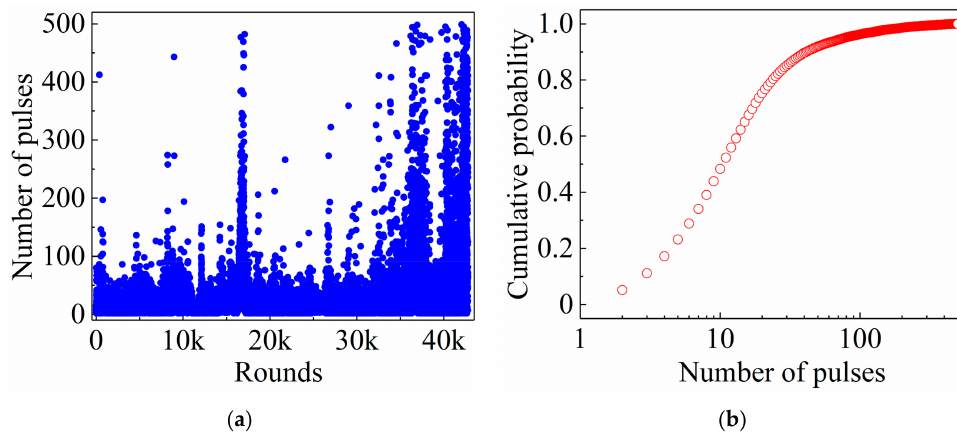
Figure 6. ( a ) Number of RESET pulses (V RESET = 0.9 V) to reach a threshold resistance (5000 Ω ). ( b ) Cumulative probability distribution of the number of